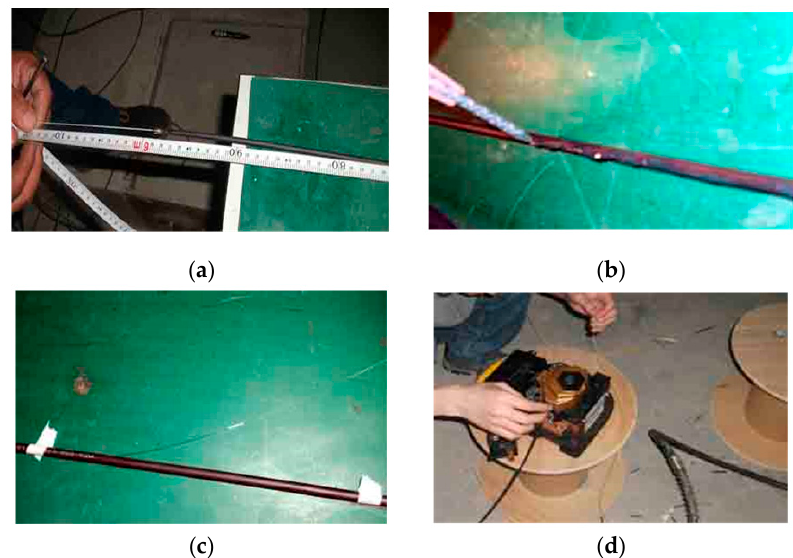
Figure 14. Preparation of test optical fiber. ( a ) Fiber length measurement. ( b ) Apply glue on the surface of SS fiber. ( c ) Adhere bare fiber to SS fiber. ( d ) Fusion of fiber and jumper.